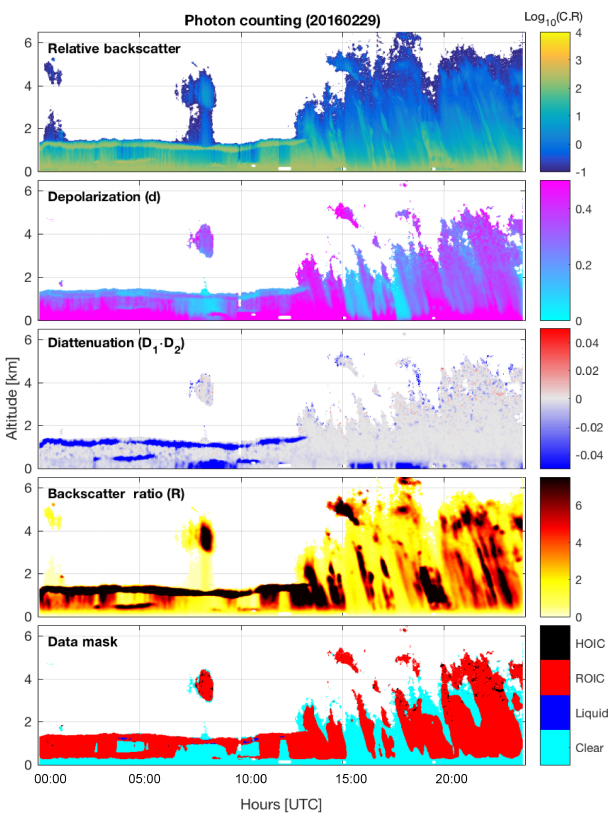
Figure 2. Same as Fig. 1 except photon counting data are shown.